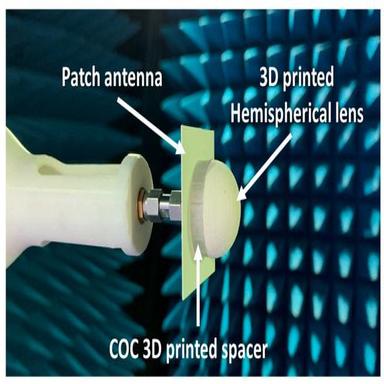
3D printed hemispherical dielectric lens using a BST/ABS composite.